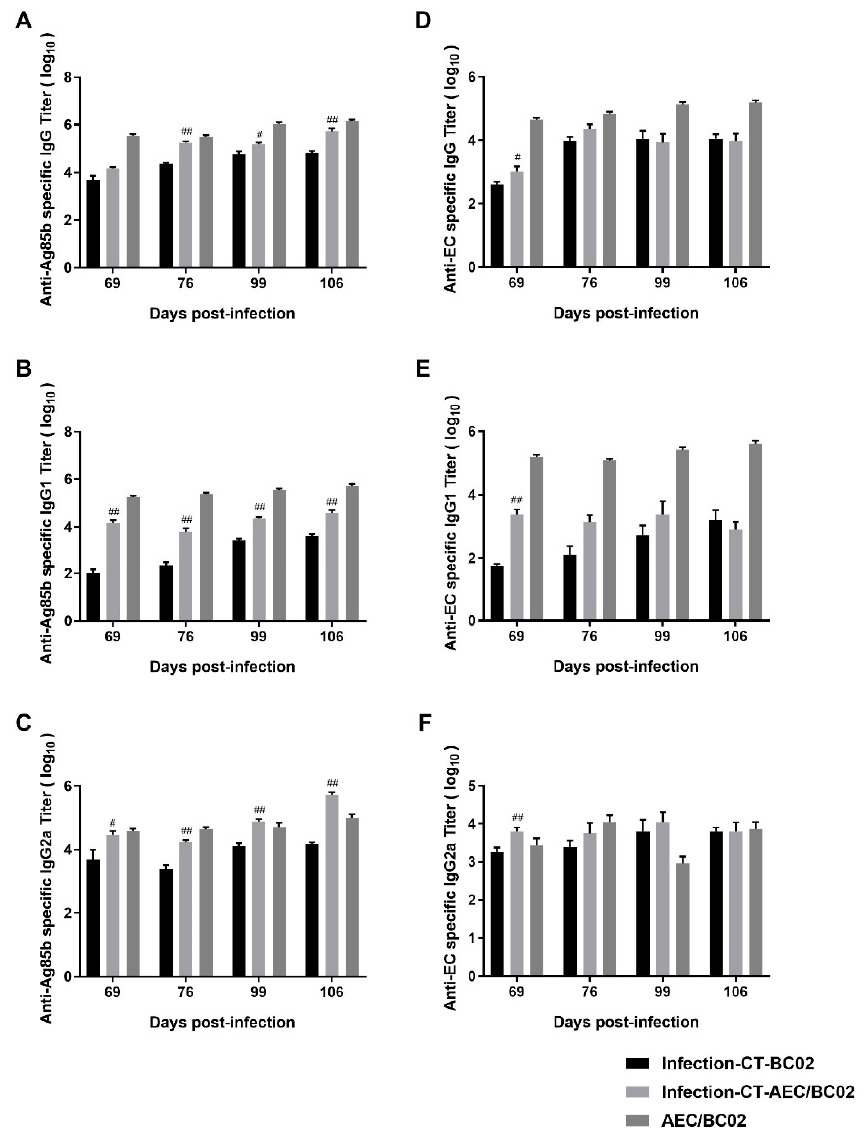
Figure 5. Characteristics of the humoral immune responses in Mtb latently infected and normal mice immunized with AEC/BC02. Ag85b-specific IgG ( A ), IgG1 ( B ), and IgG2a ( C ) in the infection-CT-BC02, infection-CT-AEC/BC02, and AEC/BC02 immunized mice were determined by ELISAs. EC-specific IgG ( D ), IgG1 ( E ), and IgG2a ( F ) in the infection-CT-BC02, infection-CT-AEC/BC02, and AEC/BC02 immunized mice were determined by ELISAs. Data from the infection-CT-AEC/BC02 group were compared with the infection-CT-BC02 group, and statistical significance was set at # p < 0.05, ## p < 0.01 ( n =